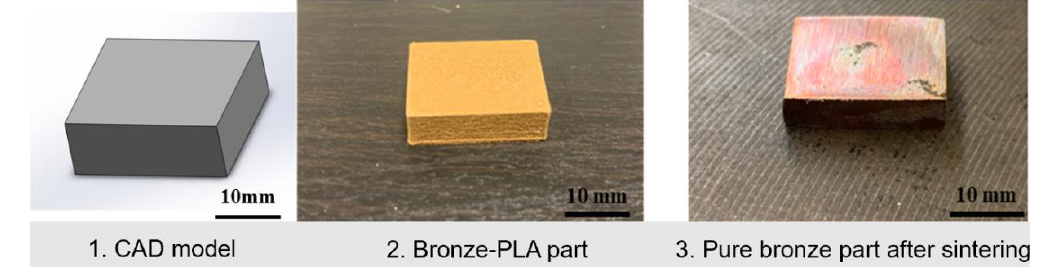
Figure 3. Samples in different status .